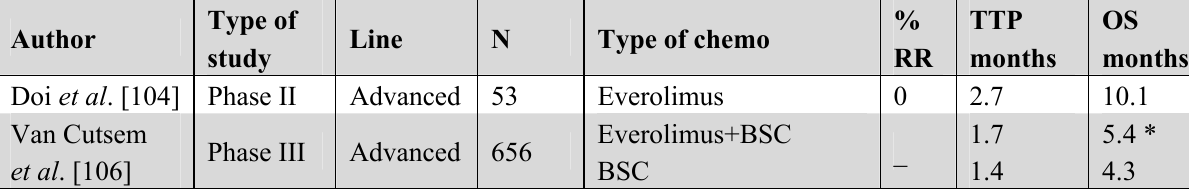
Table 6. Clinical trials with everolimus in previously treated patients with